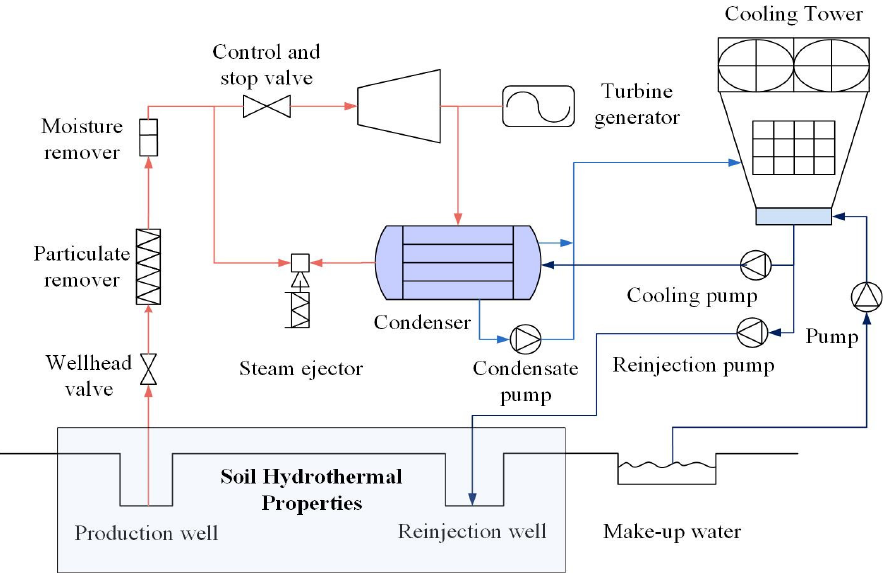
Figure 2. Simplified schematic of GPG with soil hydrothermal properties.